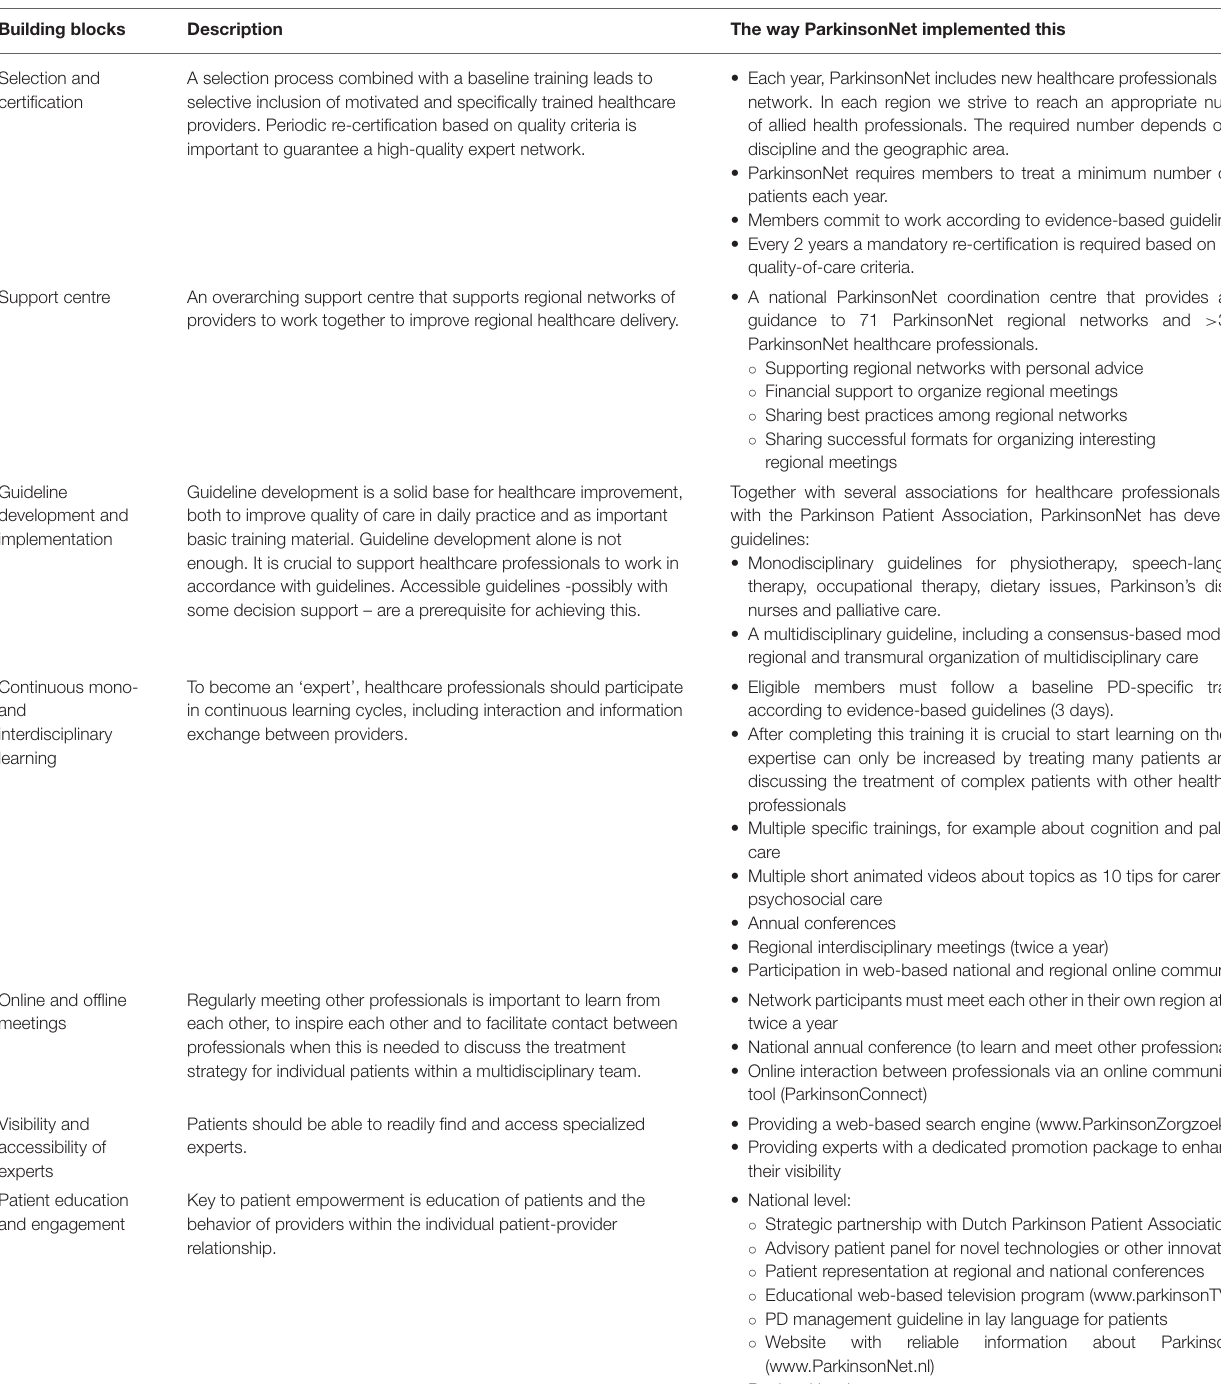
TABLE 1 | Overview of the supportive building blocks of care networks, including a detailed description and examples of how these have been implemented in